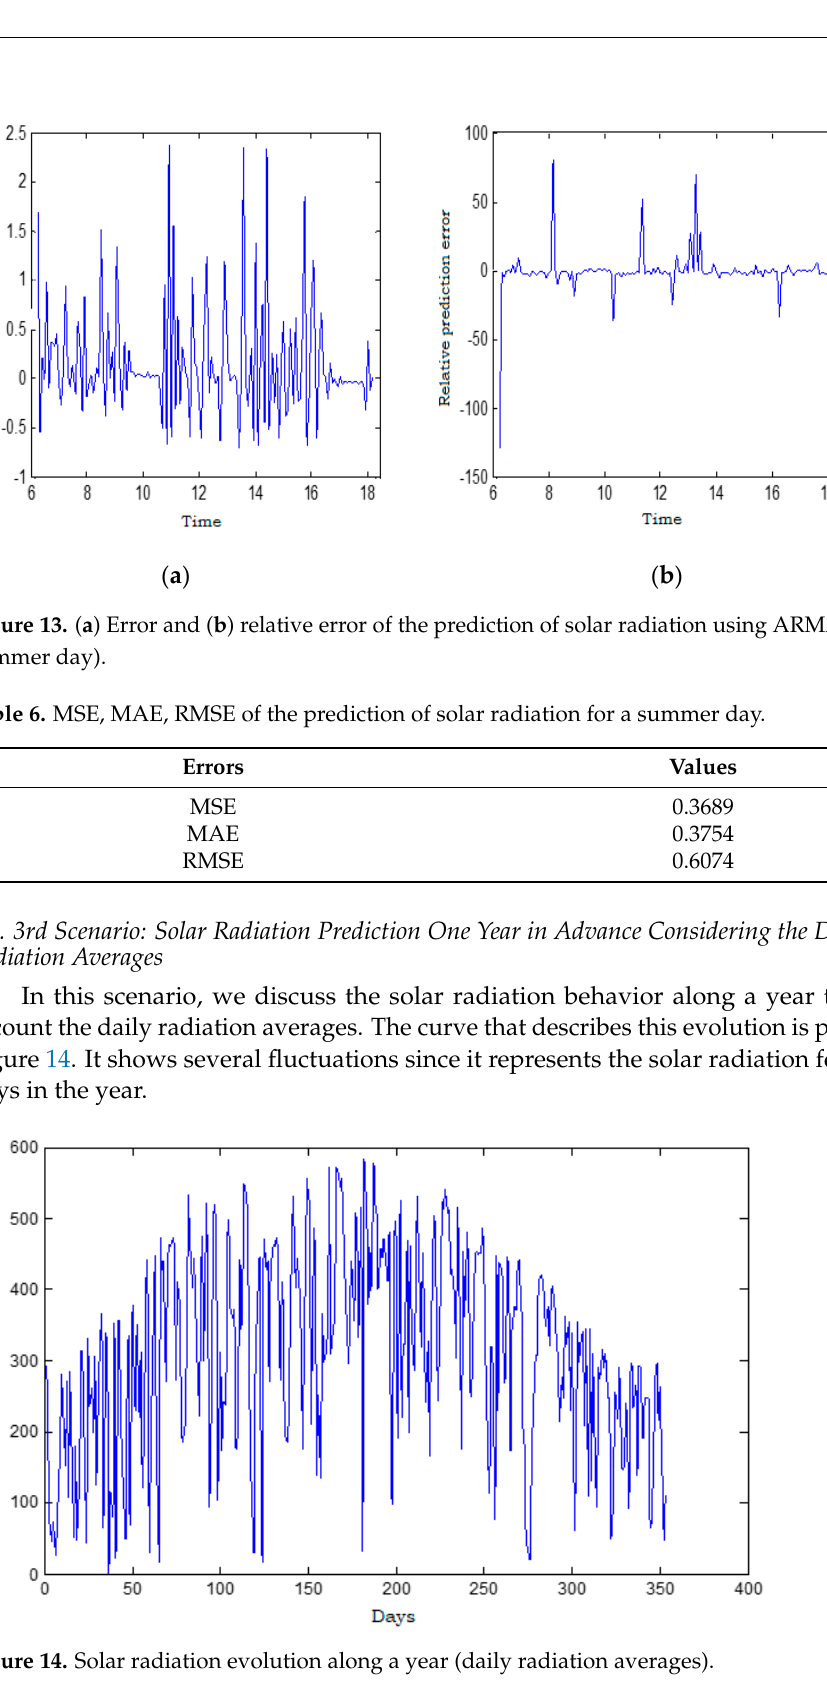
Figure 15. Relative differentiation of the solar radiation along a year (daily radiation averages). Table 7. Order and coefficients of the ARMA model (daily radiation averages). ARMA (p,q) Order Coefficients p = 4